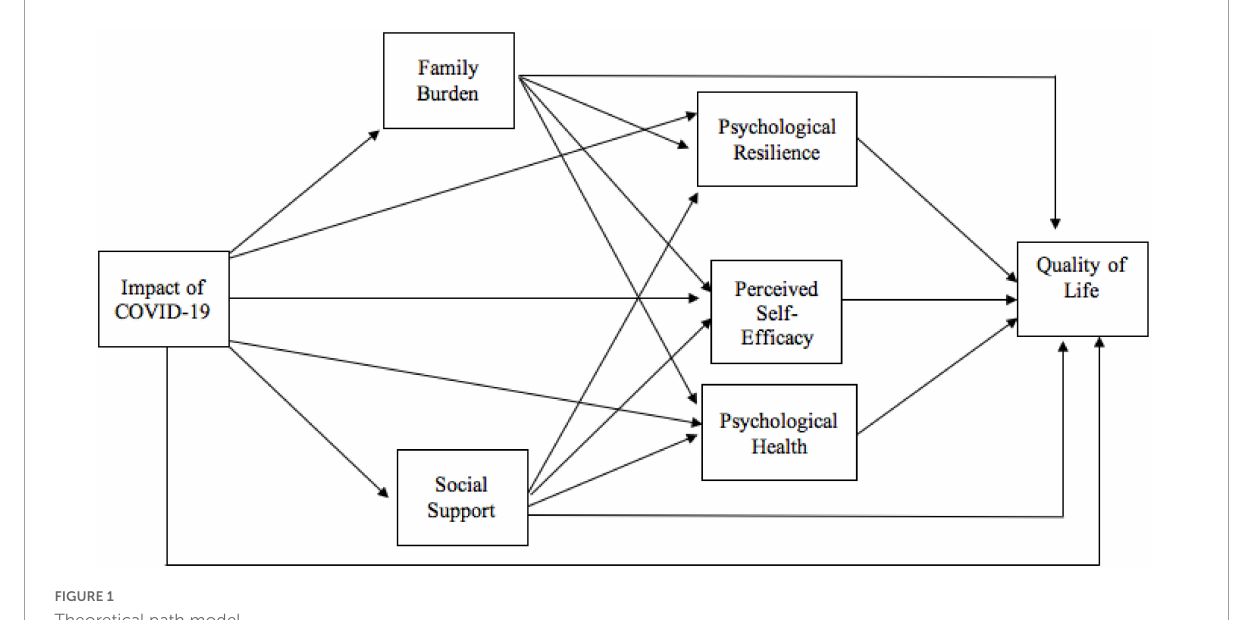
FIGURE1 Theoretical path model.